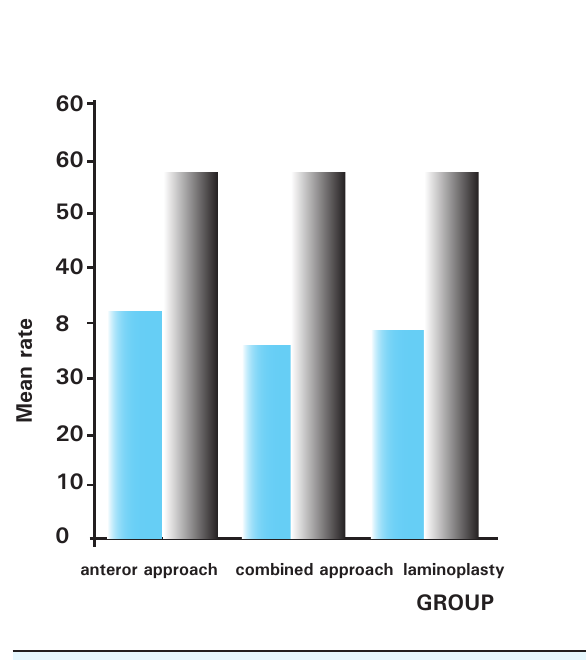
Figure 2. JOA recovery rate in anterior approach, combined antero-posterior approach and laminoplas- ty.